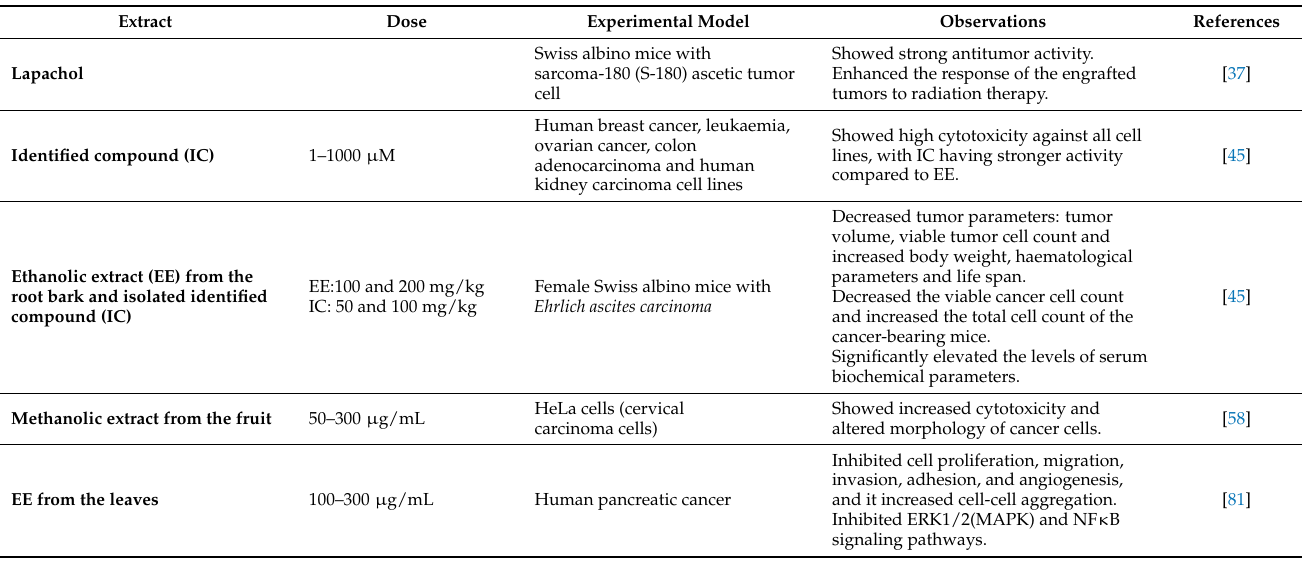
Table 7. The anticancer effects of Ziziphus nummularia